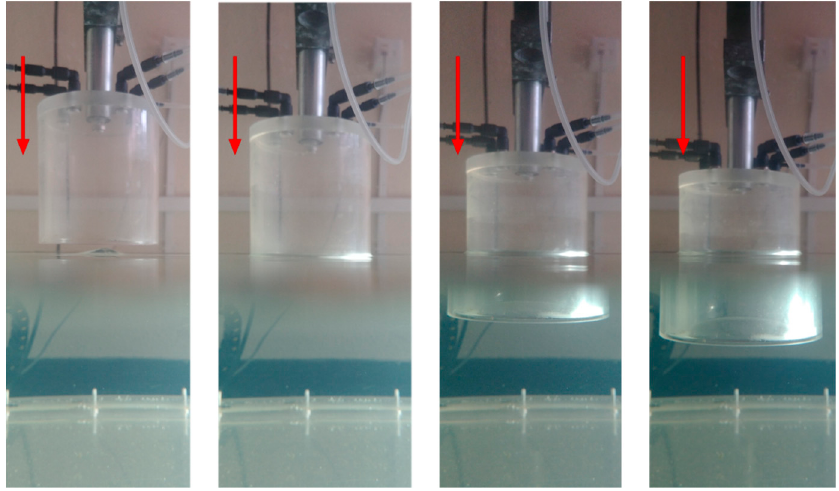
Figure 5. Movement of the air pressure chamber during the experiments.